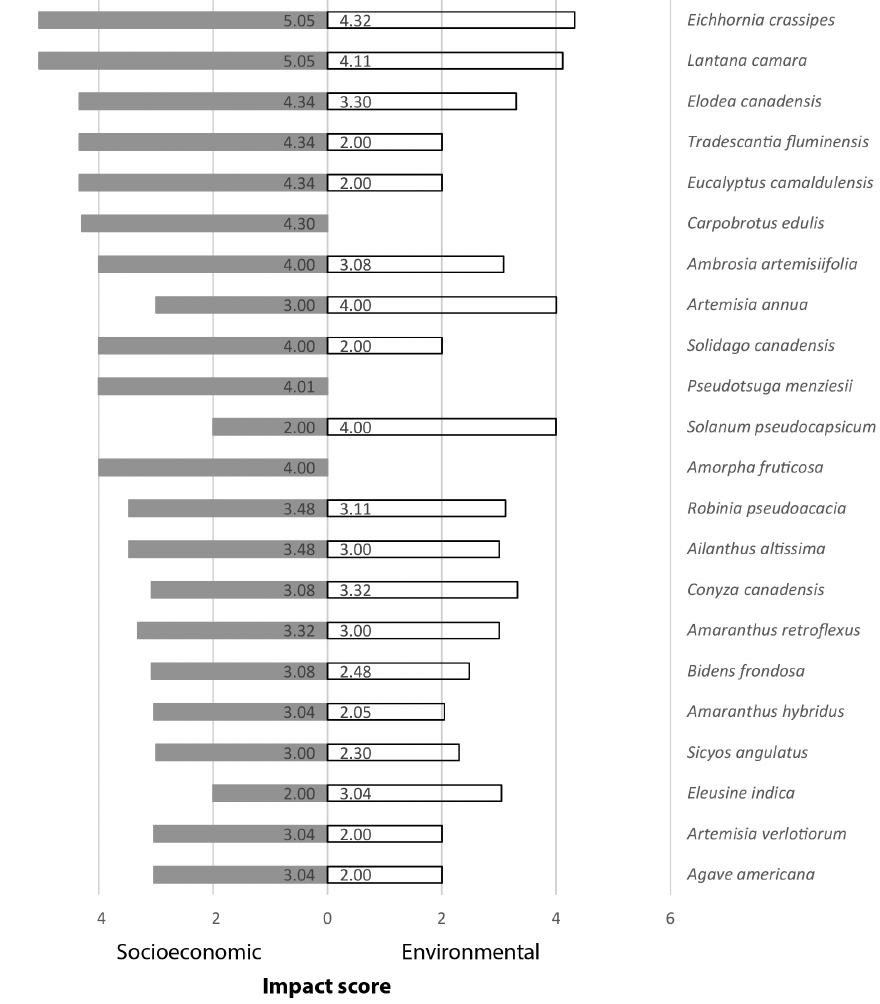
Figure 4. Top 22 alien species ranked according to decreasing logarithmic sum of all impact scores across categories of environmental (white bars) and socioeconomic (grey bars) impacts. Note that by using the logarithmic sum, the highest score recorded has the most influence on the overall score while the other scores have relatively little influence on the overall value; this approach ensures that emphasis on the maximum impact of species is